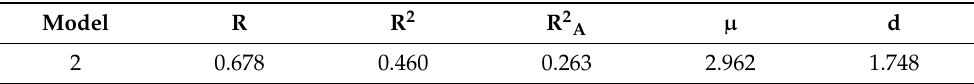
Table 9. The basic parameters of the regression statistics for the two-factor model of the functional relationship between digitalization factors and the absolute liquidity